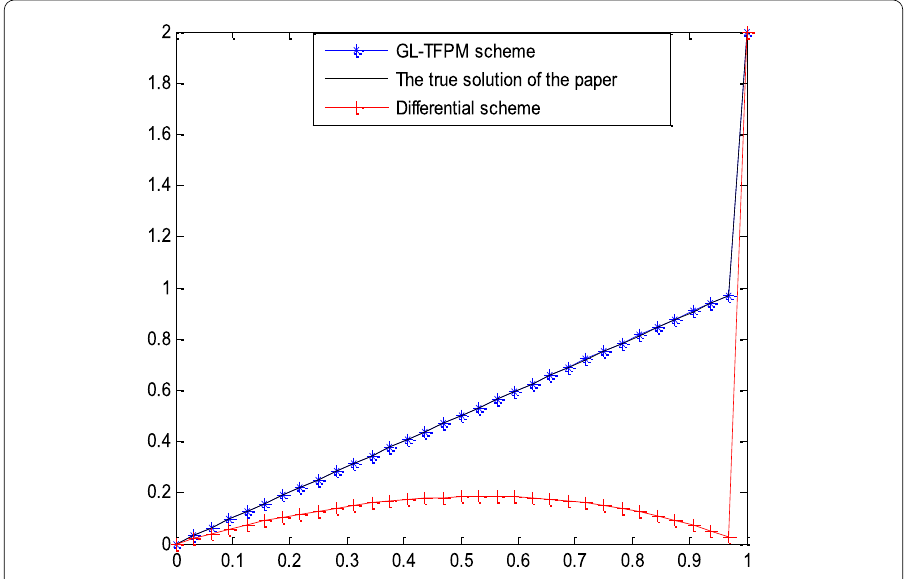
Figure 3 Comparison of GL-TFPM and DM